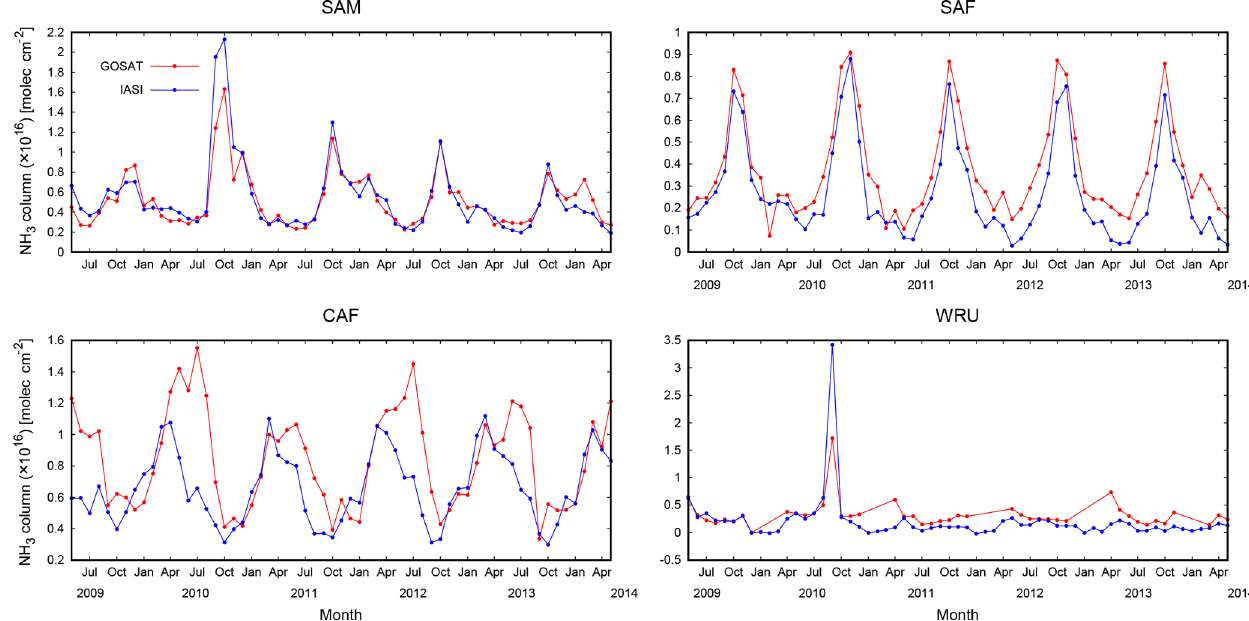
Figure 10. Same as Fig. 9, but for the biomass burning